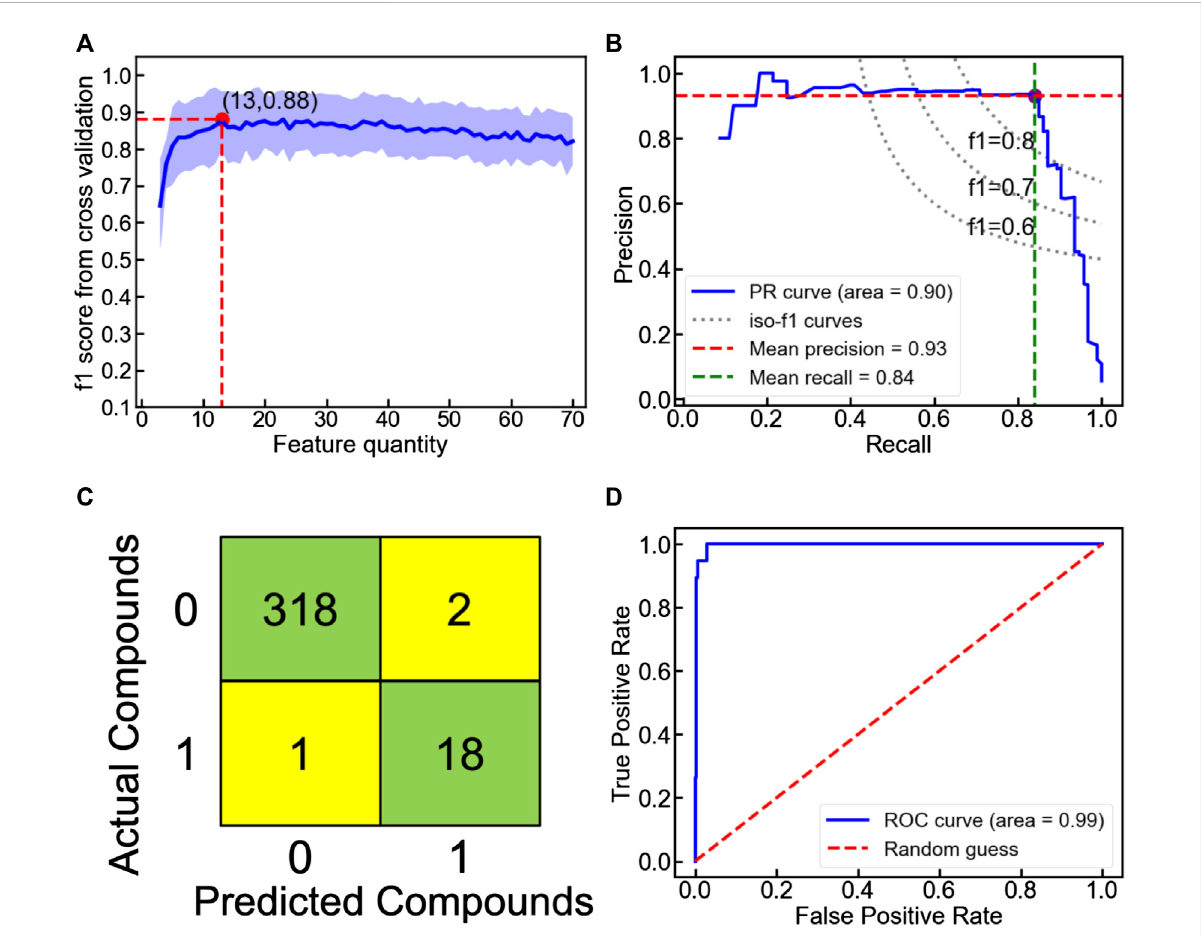
FIGURE 8 (A) Ten-fold cross-validated f1 score as a function of feature quantity in the voting classi fi cation model to categorize the unmixed oxyhydrides. The shaded region represents the standard deviation of f1 score upon cross validation. (B) Precision-recall, (C) confusion matrix and (D)